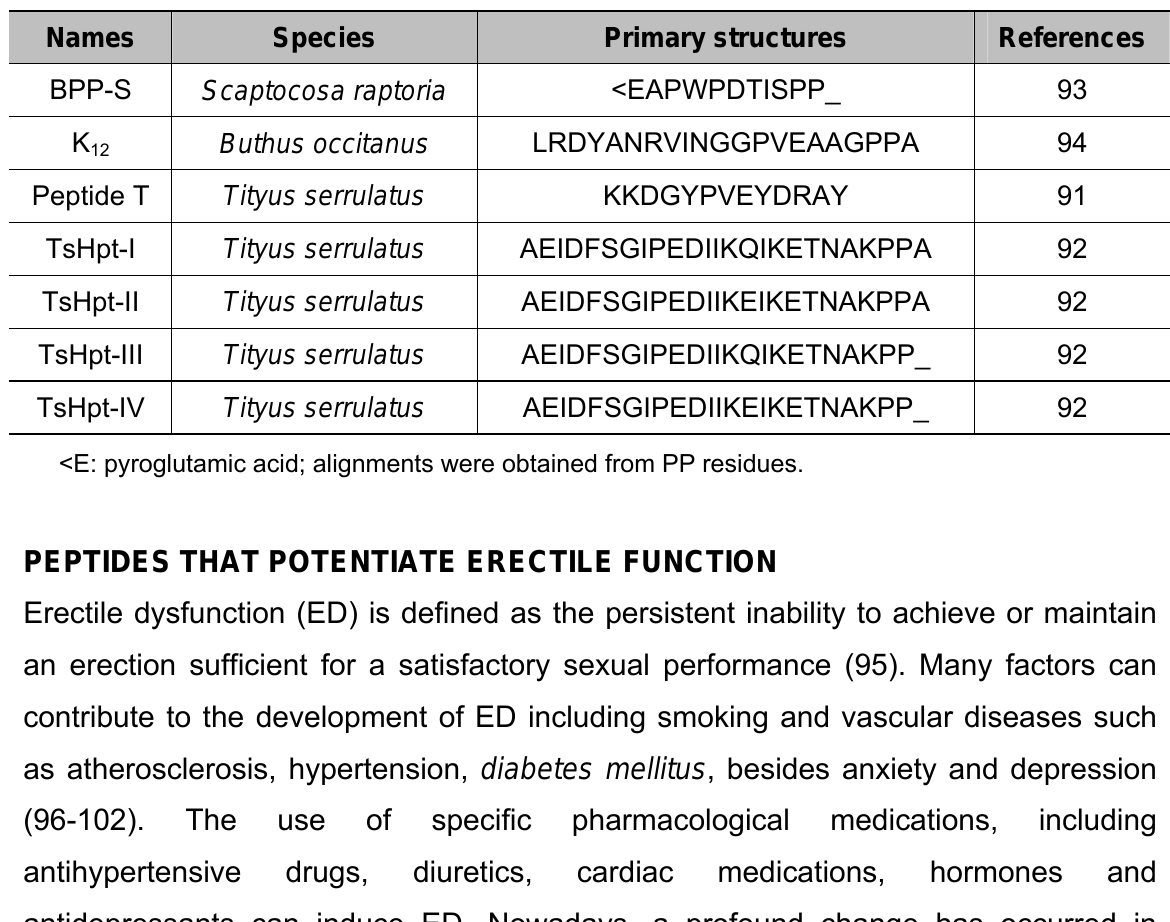
Table 1 – BPPs isolated from arthropod